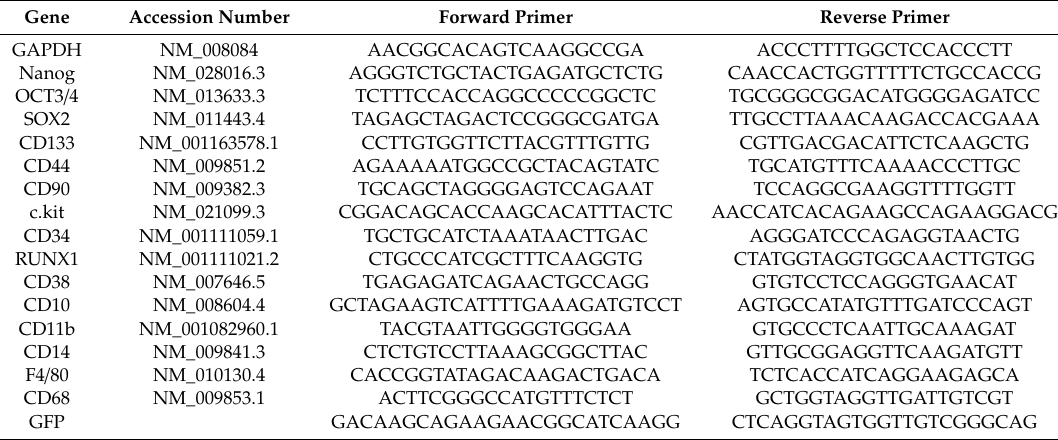
Table 1. Sequences of primers used in the